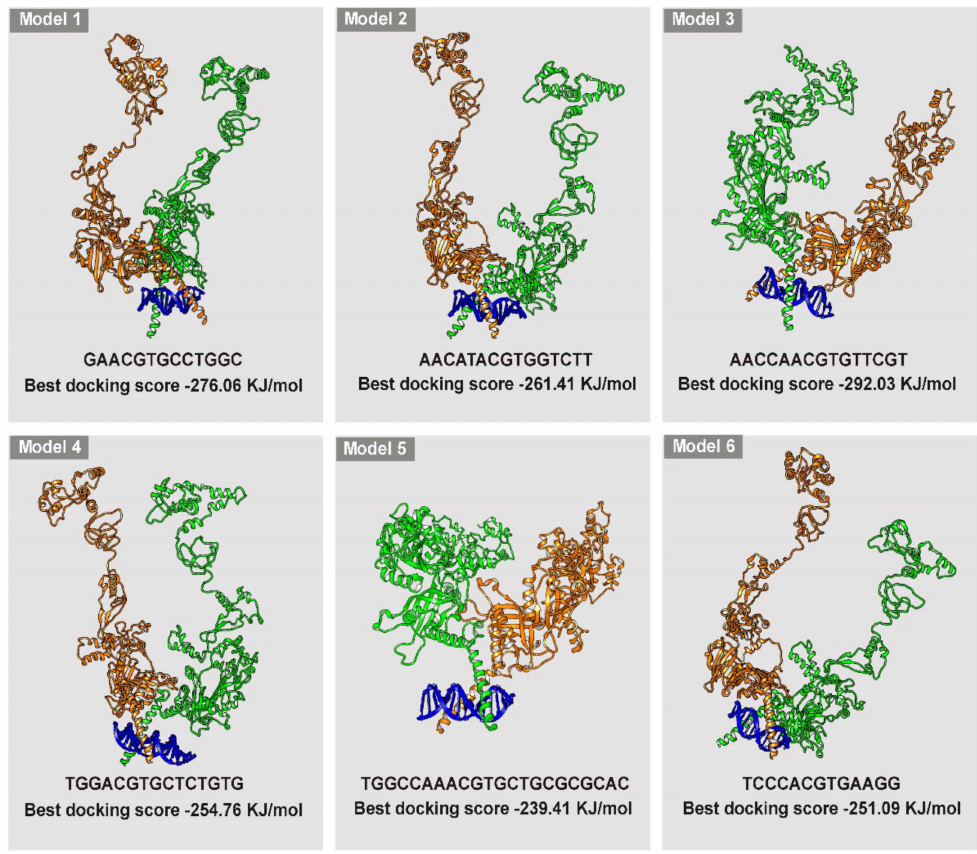
Figure 4. Graphical representation of the 6 HIF-1/DNA models displaying the 3D reconstruction of the HIF-1 docking to each of the nucleotide sequence, including HBS and flanking sequences, and their relative best docking score in